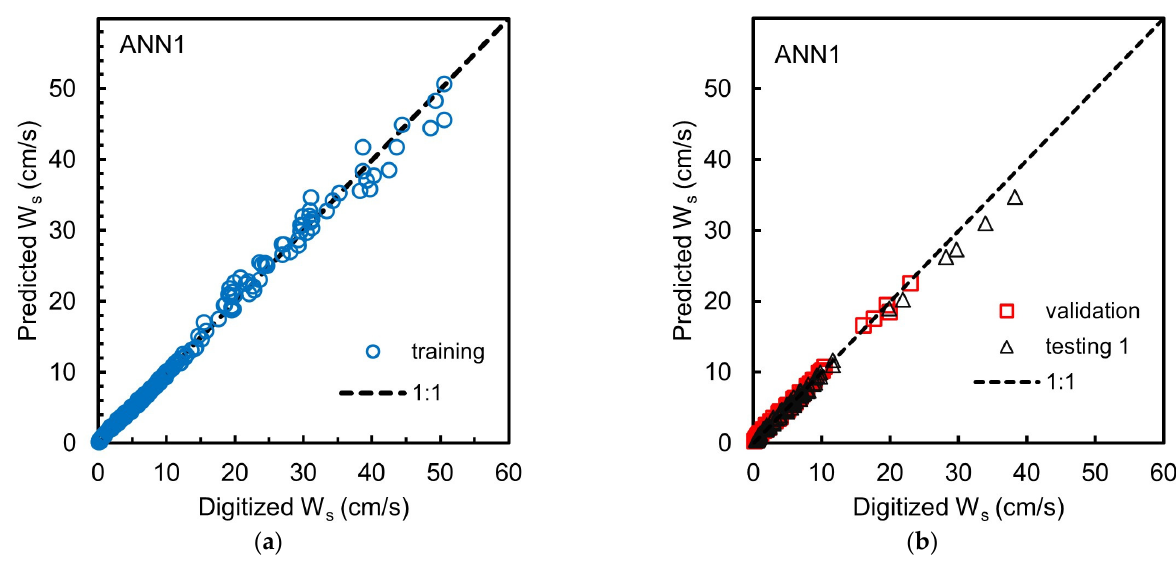
Figure 2. Scattering plot for results of training ( a ) and validation and testing 1 for ANN1 ( b ).